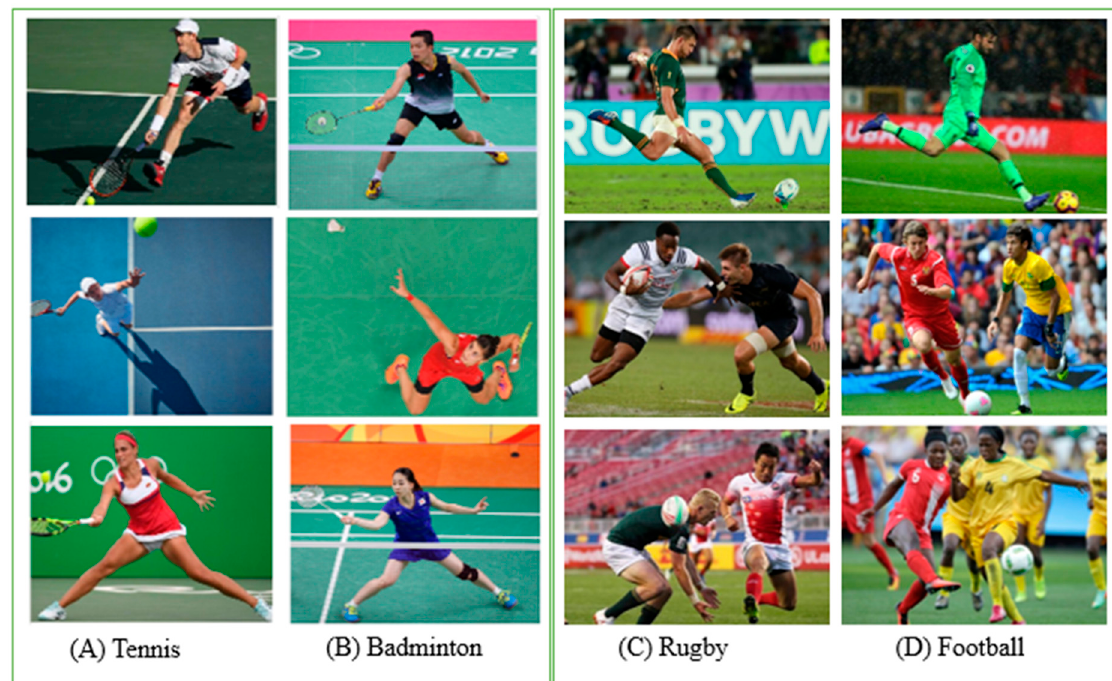
Figure 1. OGED dataset images. Illustration of similarities between Tennis and Badminton ( A , B ) and between Football and Rugby ( C , D ), which can be easily misclassified.